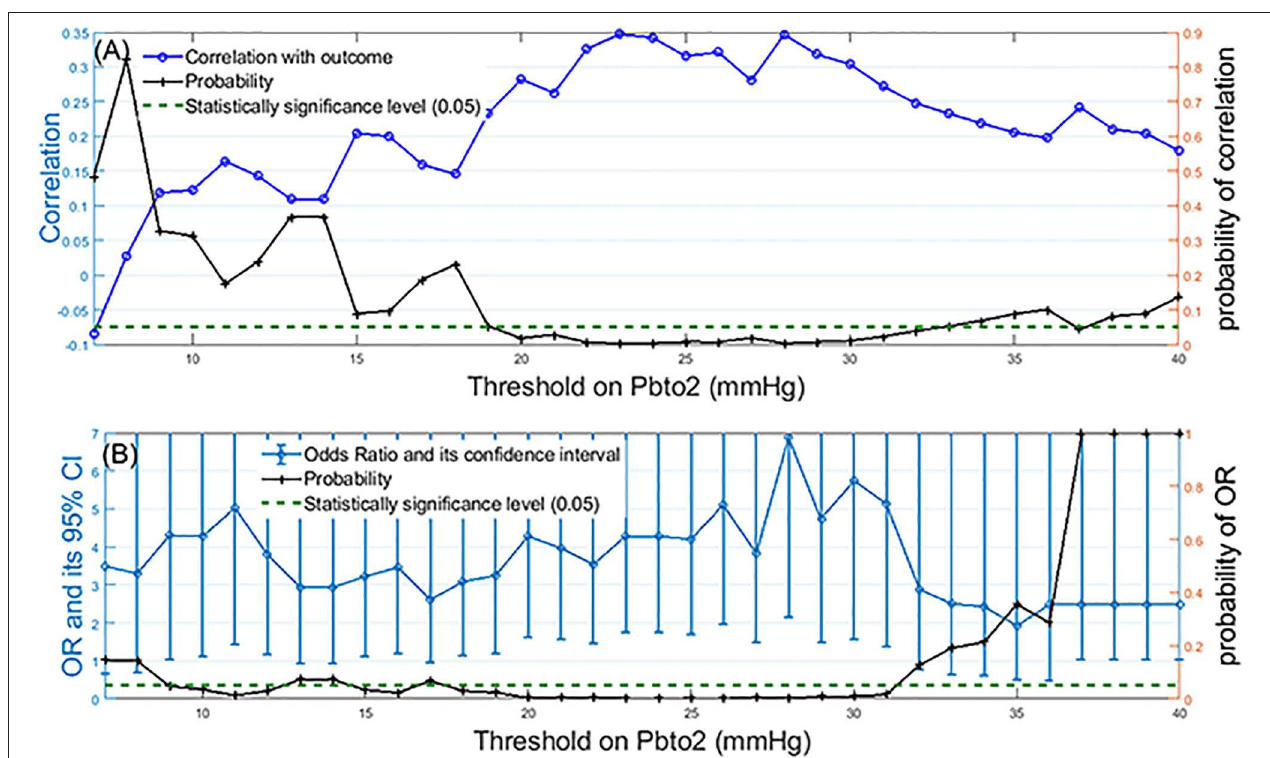
FIGURE 1 | Identification of the optimal threshold on PbtO2 to define hypoxia: (A) Left-side vertical axis shows correlation values between the percentage of episodes with compromised PbtO2 and the mortality outcome over all patients when the PbtO2 threshold (shown as horizontal axis) changed from 7 to 40 mmHg. Right-side vertical axis displays the probability of the significance of the calculated correlation for each threshold value. (B) Left-side vertical axis displays odds ratio and its 95% confidence interval for mortality detection by using dichotomized PbtO2 (PbtO2 < Threshold or ≥ Threshold) as the input of generalized estimating equations while adjusting for confounding factors such as intracranial pressure (ICP), cerebral perfusion pressure (CPP), age and gender. The right-side vertical axis displays the probability associated with calculated OR. The dashed green line represents the probability significance level of 0.05. So, any probability below the dashed green line is statistically significant.